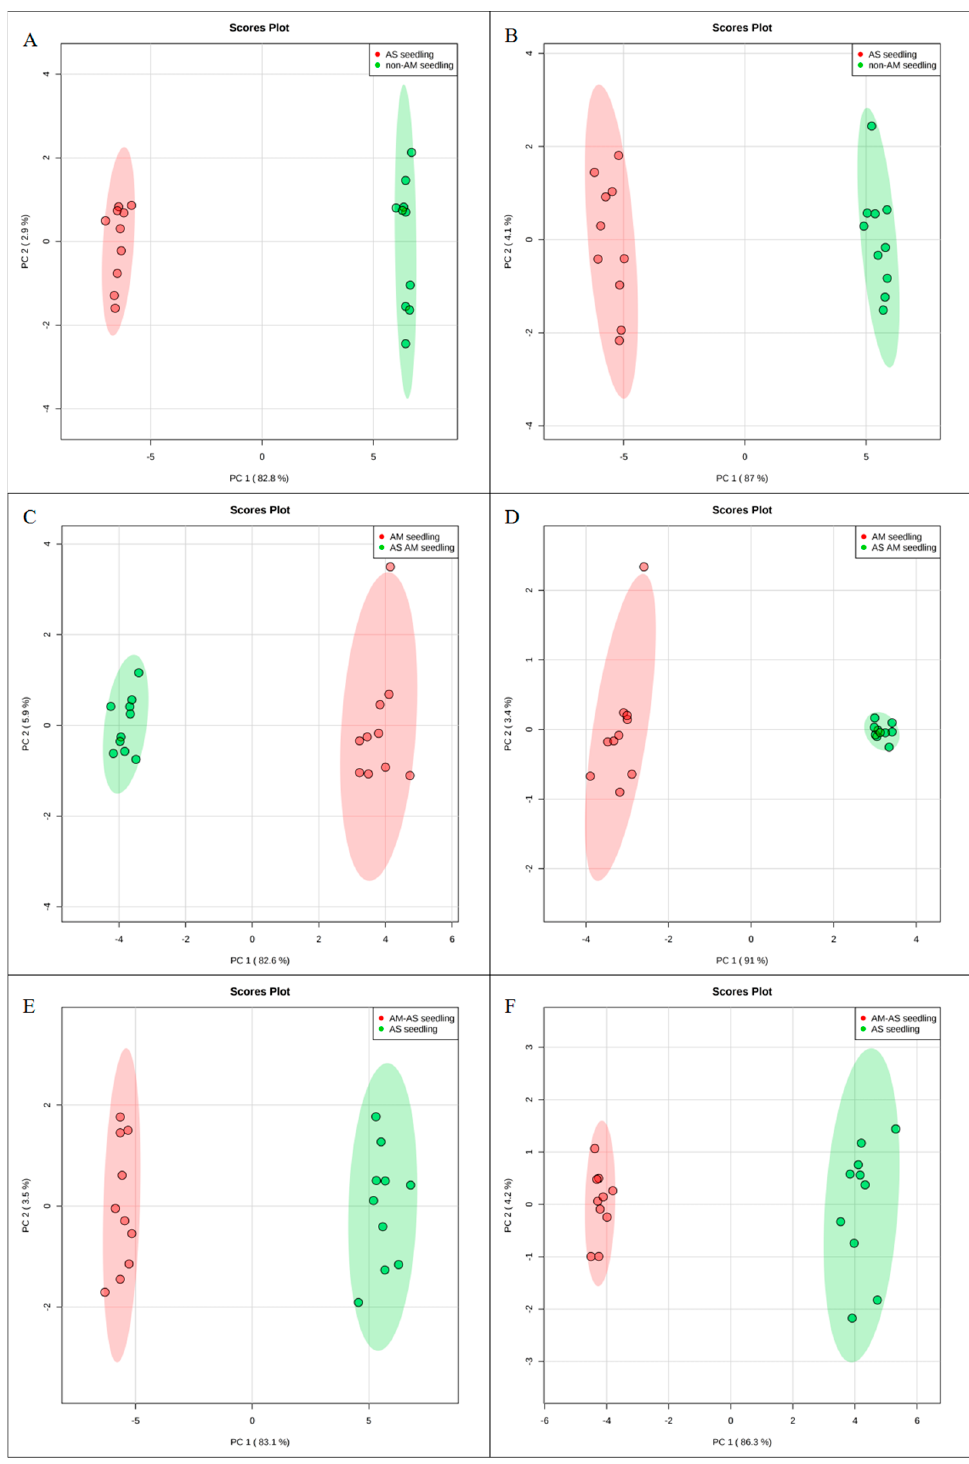
Figure 2. Principal component analysis (PCA) score plots of metabolic profiles in non-AM seedlings in response to alkali stress ( A , B ), AM seedlings in response to alkali stress ( C , D ) and comparison in non-AM seedlings and AM seedlings under alkali stress ( E , F ) in positive ( A , C , E ) and negative modes ( B , D , F ). PC1 and PC2 are the first two principal components.